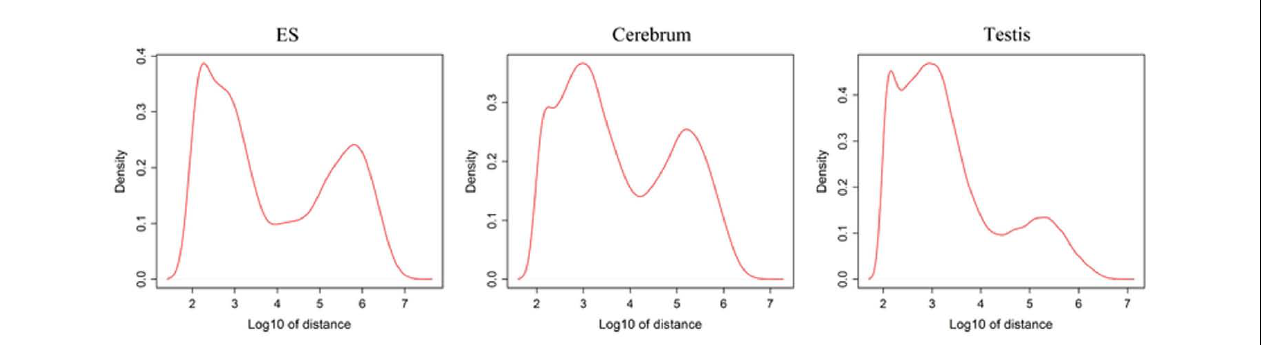
length and this peak implies the minimal introns. In addition, the first main peak represents the distance of general adjacent exons insideTUs and the second main peak is related to the distance of exons between